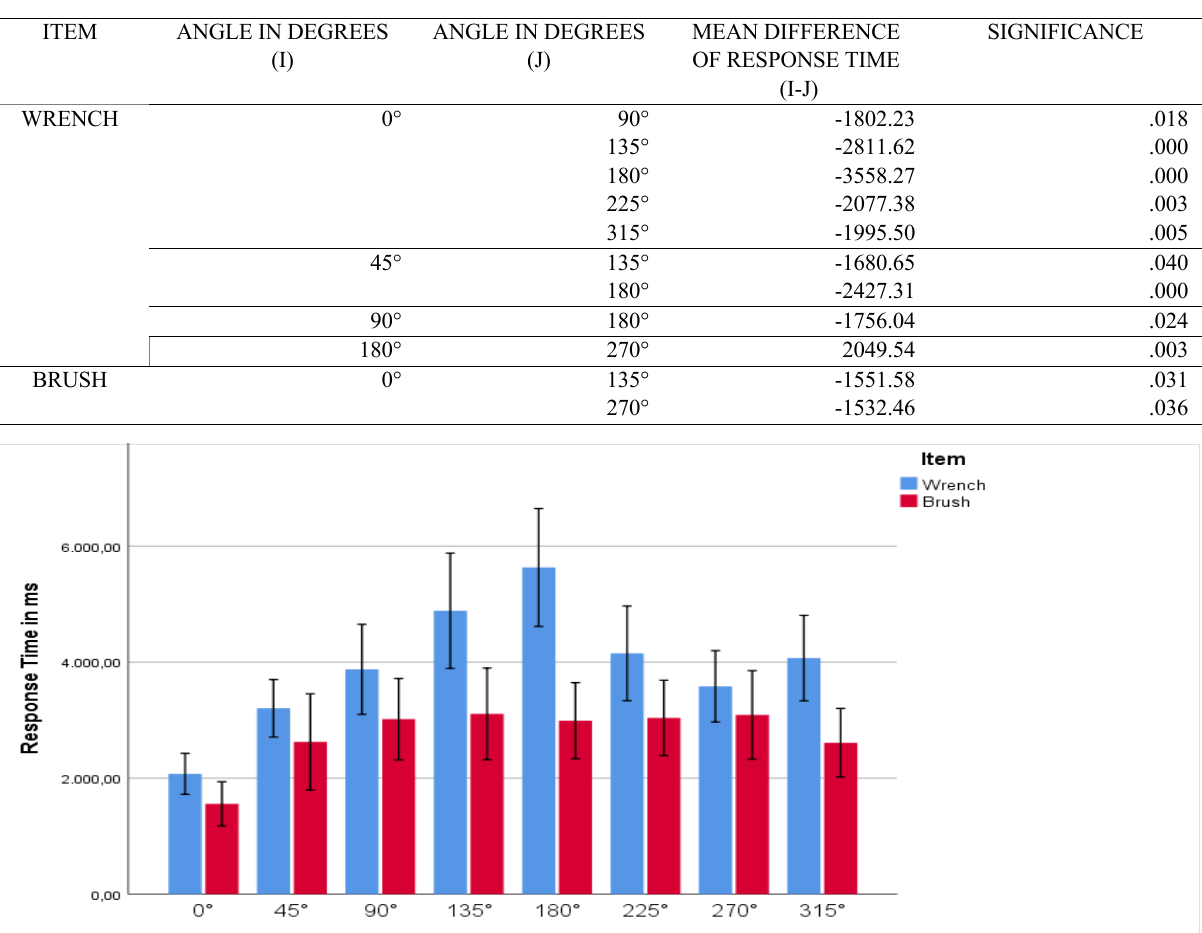
Table 2: Results of Bonferroni corrected post-hoc tests for univariate ANOVA (angle and response time).